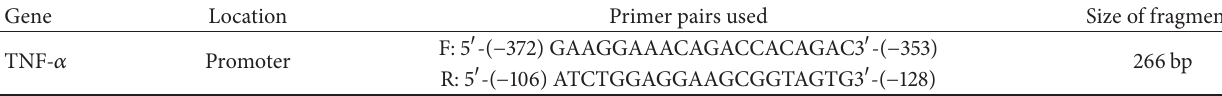
Table 1: Technical data for the analysis of TNF- 𝛼